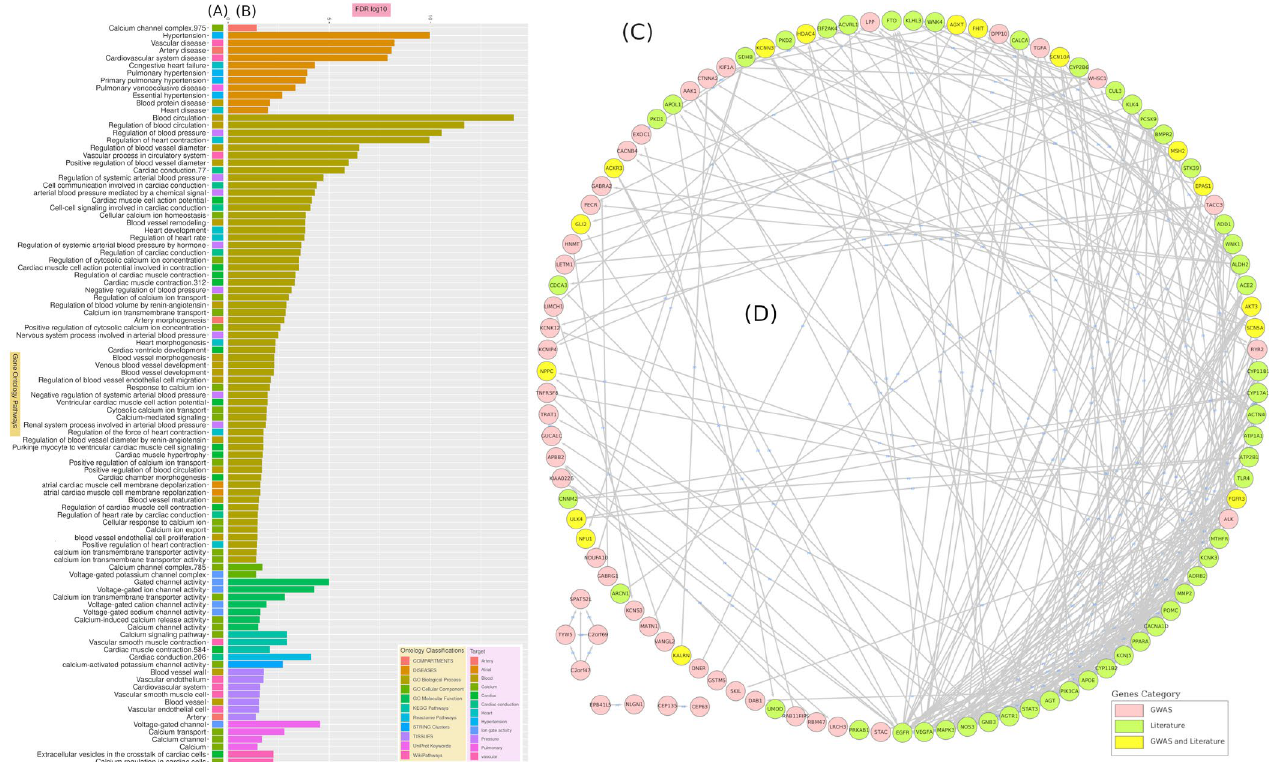
Figure 7. The gene ontology and PPI analysis of highly frequently occurring genes that are associated with EH in both the literature and our GWAS analysis. The most important gene ontology terms associated with EH ( A ) and their ontology class ( B ). The PPI interaction ( C ) of EH-associated genes found through GWAS and literature analysis separately and together; connecting lines ( D ) signify the biological interactions.